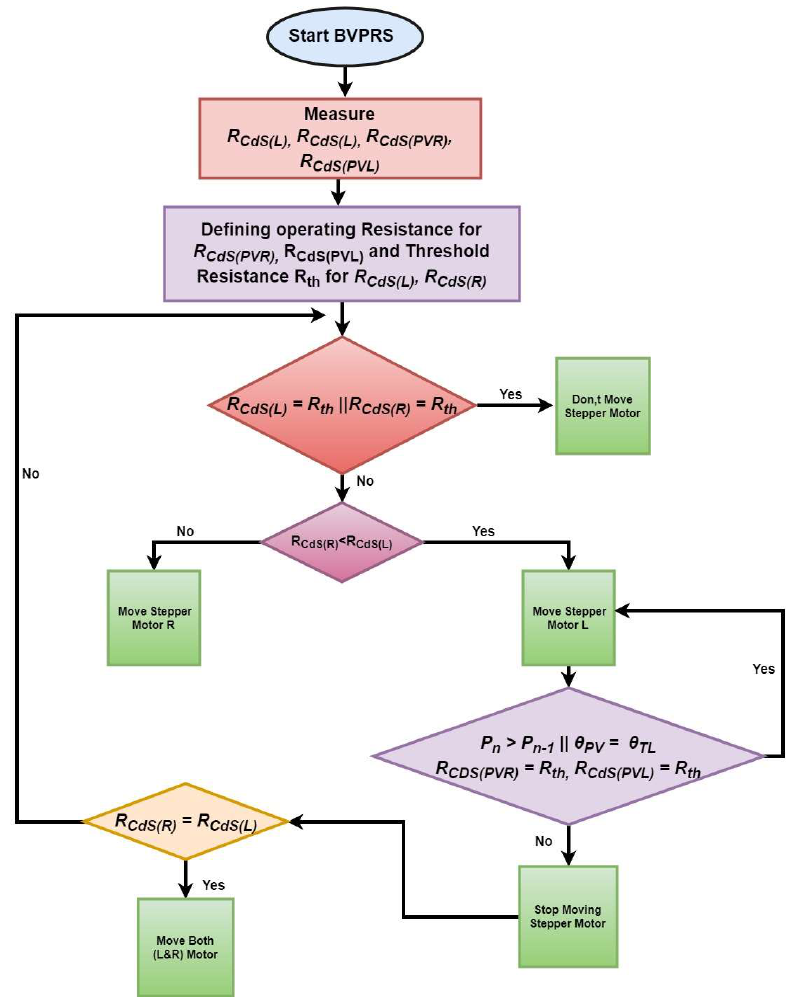
Figure 8. Flowchart explaining control algorithm for operating BRS.